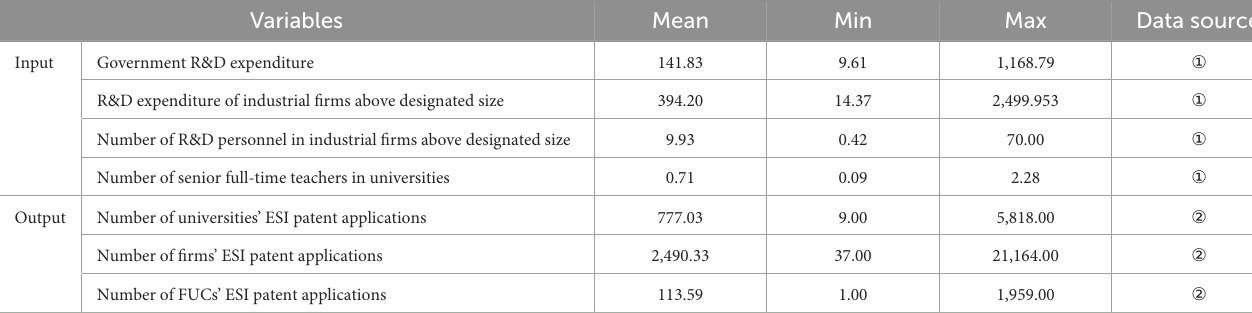
TABLE 1 Input-output variables of SBM model and data sources ( N = 243).